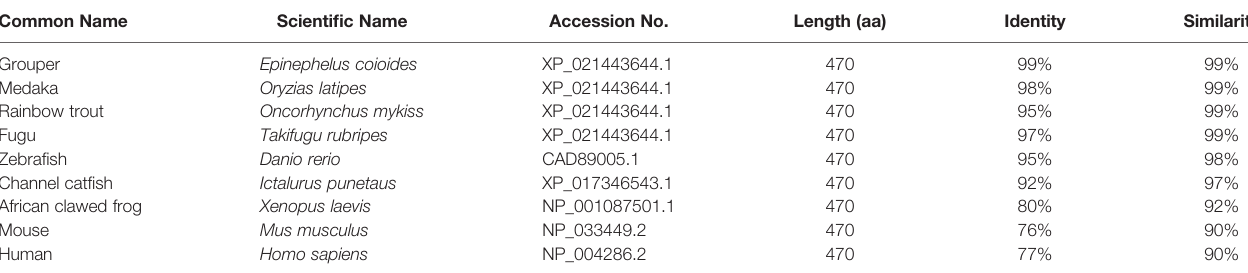
TABLE 2 | Amino acid identity and similarity among Lc -TRAF4 and TRAF4 from other